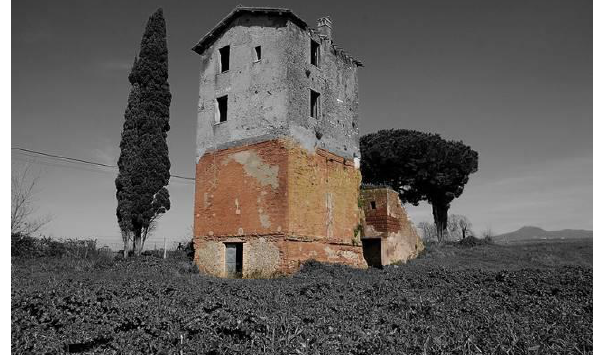
Figure 3. An example of reuse of Roman pre-existing buildings: the tower of Santa Maria in Fornarola, built on the remains of a domuscultae (in color in the image).